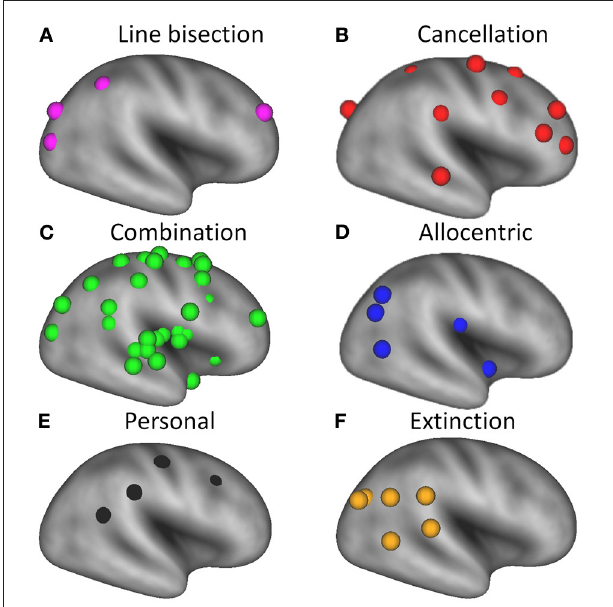
FIGURE 3 | Overview of brain regions associated with different deficits in patients with unilateral spatial neglect, superimposed on a very inflated template brain using CARET software (v5.64 http://brainmap.wustl.edu/caret.html). Purple spheres = neglect tested with line bisection tasks; red spheres = neglect tested with cancellation tasks; green spheres = neglect tested with a combination of tasks; blue spheres = allocentric neglect; black spheres = personal neglect; orange spheres = spatial